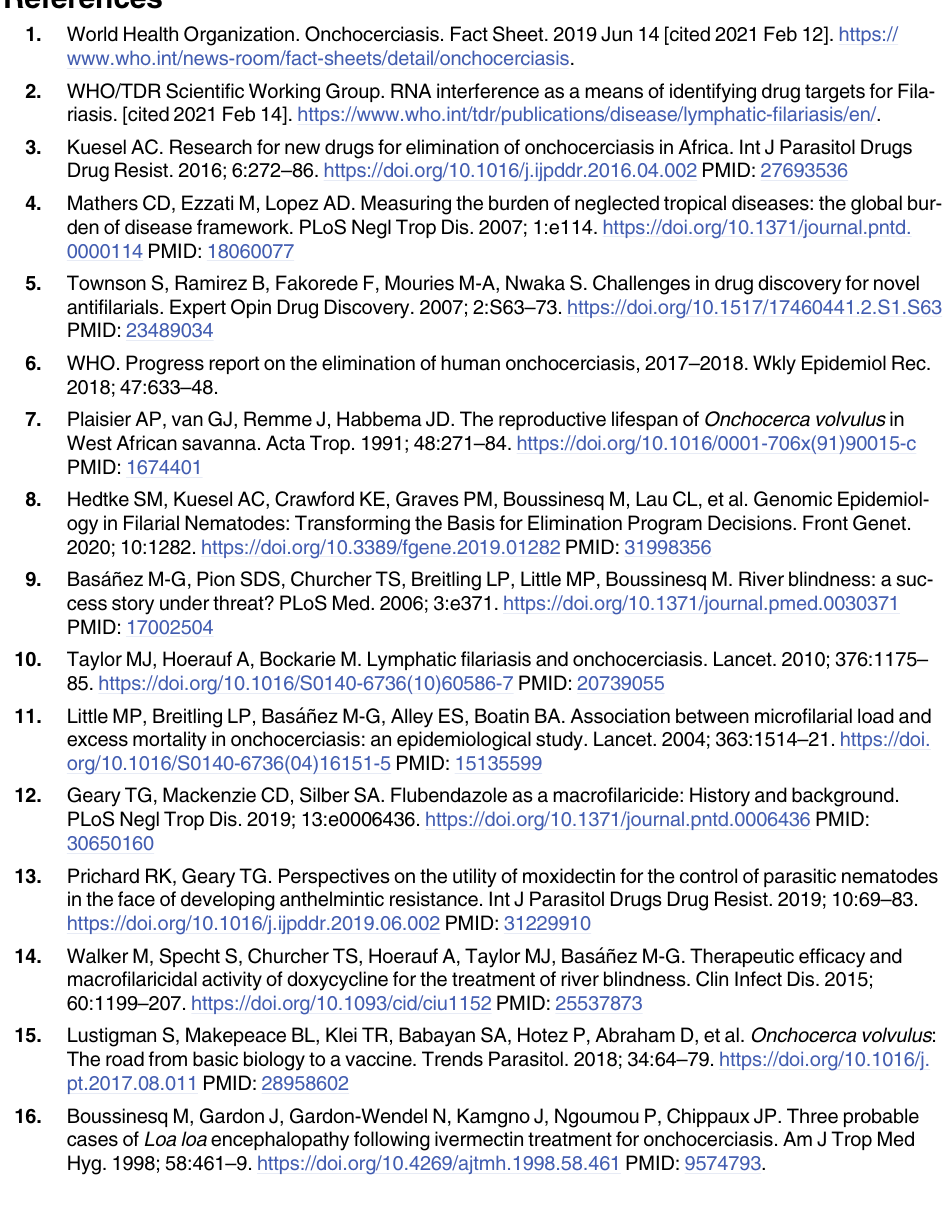
S1 Table. SLO-1 protein database entries included in the phylogenetic analysis. SLO-1, slowpoke big K + conductance channel. S2 Table. Efficacy studies for emodepside against Trichuris spp., ascarids, hookworms, and Strongyloides ratti